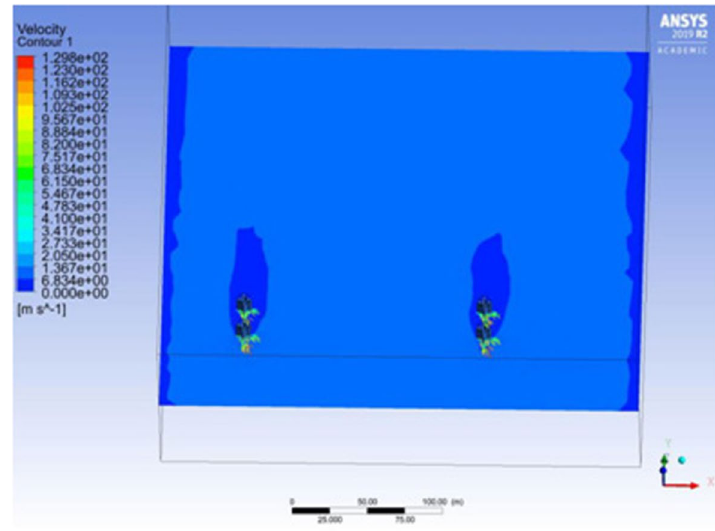
Fig. 7 Vertical wind turbine positioned on the main shaft of the ship (image projected in ANSYS Fluids, in the XY plane) (Vasilescu and Dinu